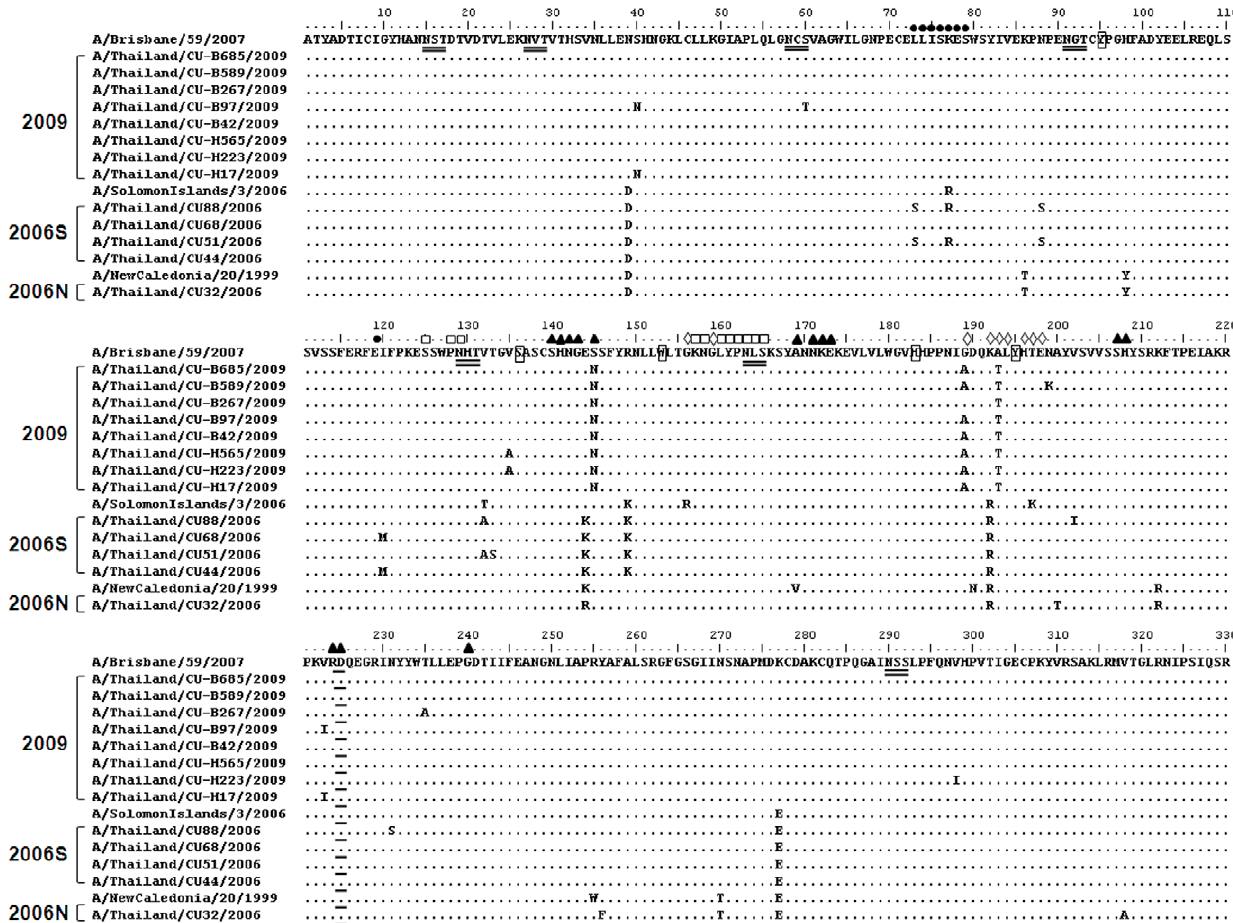
Figure 3. Amino acid comparison between HAl domains of H1N1 isolates and vaccine strains. Dots represent amino acids similar to the consensus. The conserved amino acid residues at the receptor-binding site are shown as small rectangles. Alternative amino acids for sialic acid linkages of HA are underlined. The amino acid residues mapped at previously defined antigenic sites are shown as follows: site Sa ( % ), site Sb ( e ), site N ).The the potential N-glycosylation sites, with threshold value of . 0.5, are double-underlined. 2009 represents the circulating Ca ( m ), and site Cb ( strain in 2009 which belong to A/Brisbane/59/2007-like lineage. 2006S represents the circulating strain in 2006 which belong to A/Solomon Island/3/ 2006-like lineage. 2006N represents the circulating strain in 2006 which belong to A/New Caledonia/20/1999-like